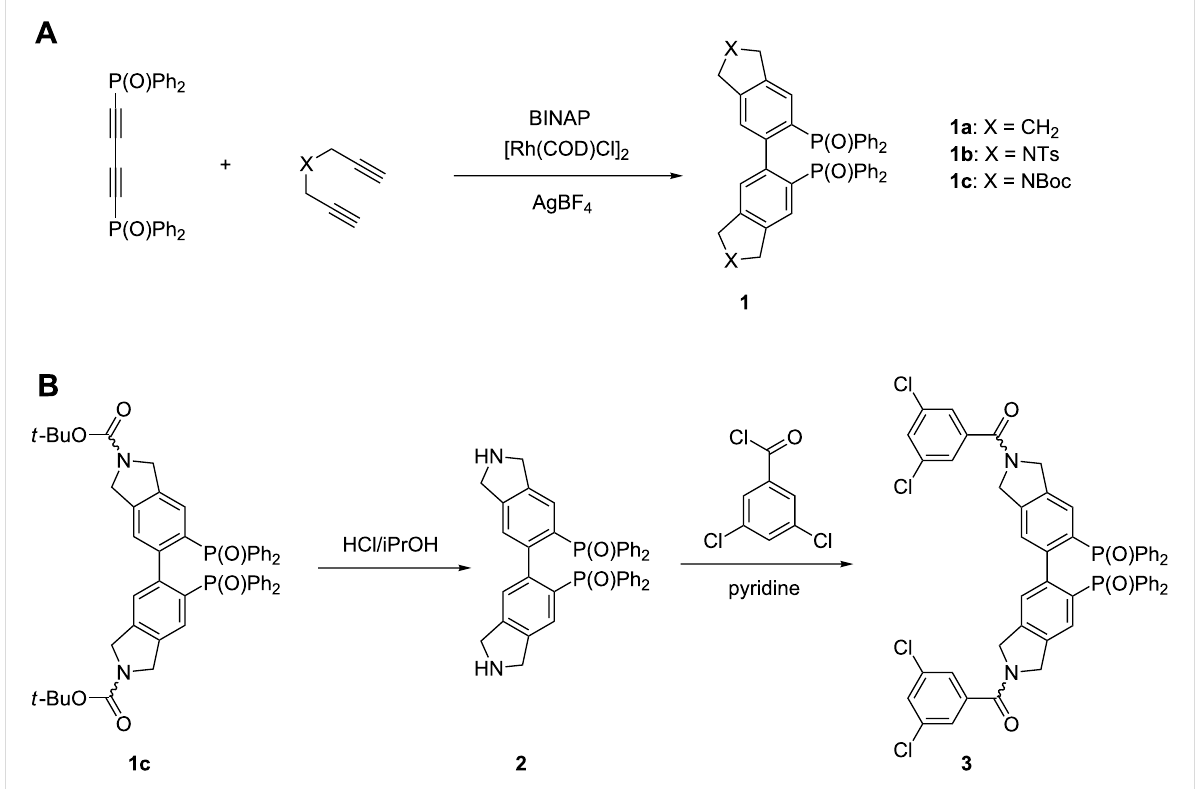
Figure 1: Synthetic overview of “NU-BIPHEP(O)s”. A) Rhodium catalyzed double [2 + 2 + 2] cycloaddition. B) Acidic deprotection of tetrahydrobiisoin- dole “NU-BIPHEP(O)” 1c and subsequent amide bond formation with 3,5-dichlorobenzoyl chloride.